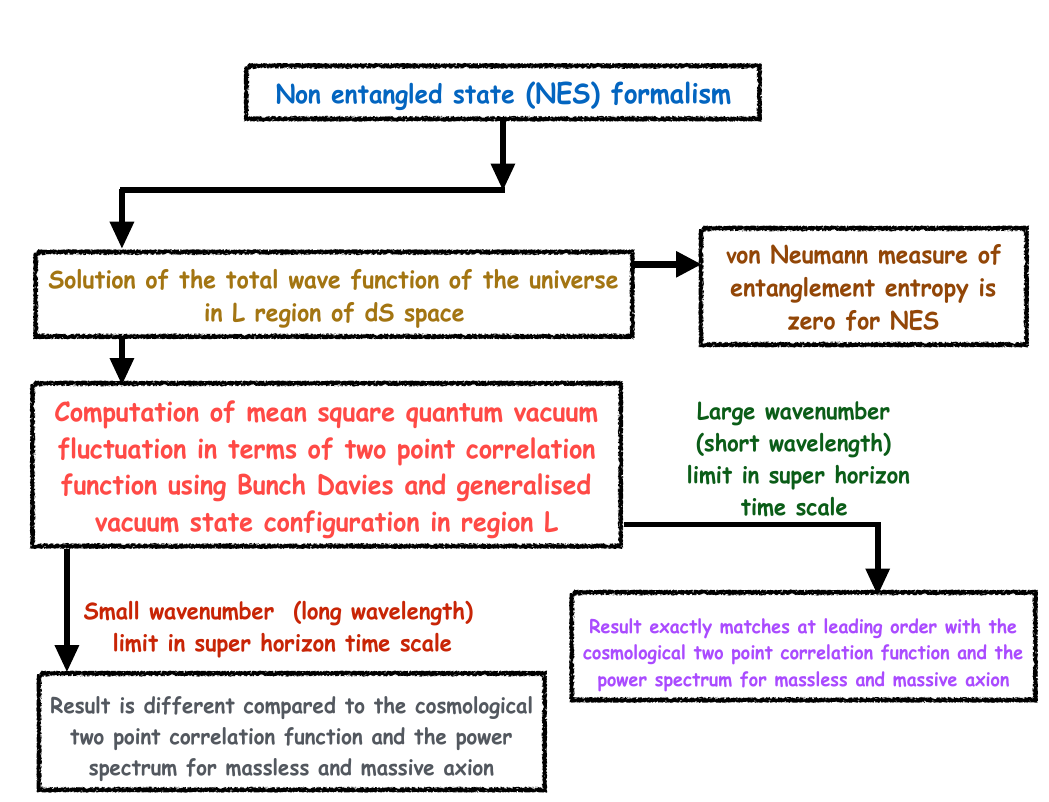
Figure 11. Schematic diagram for the computation algorithm of NES formalism for non entangled quantum state of axion in de Sitter hyperbolic open